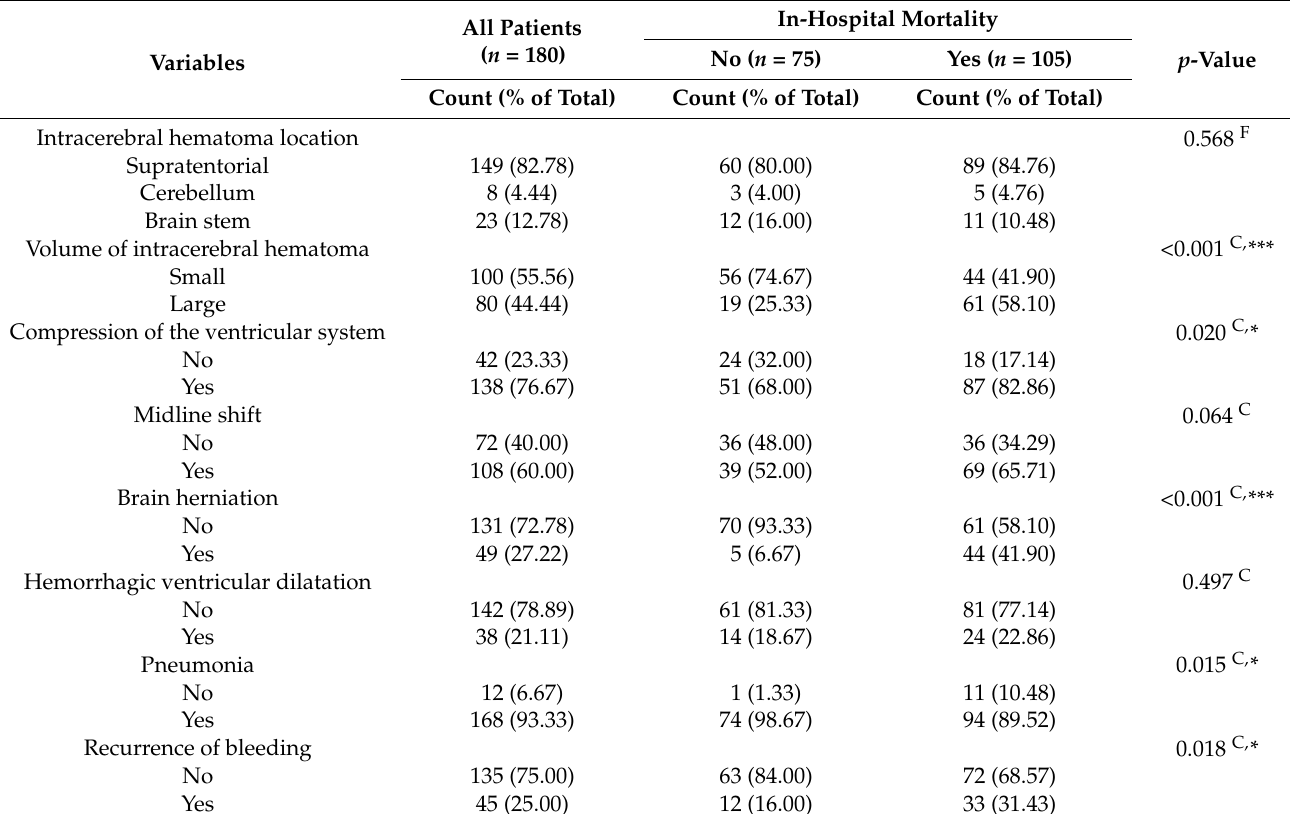
Table 3. Computed tomography (CT) imaging features in the in-hospital survival and in-hospital mortality patients with ICH.